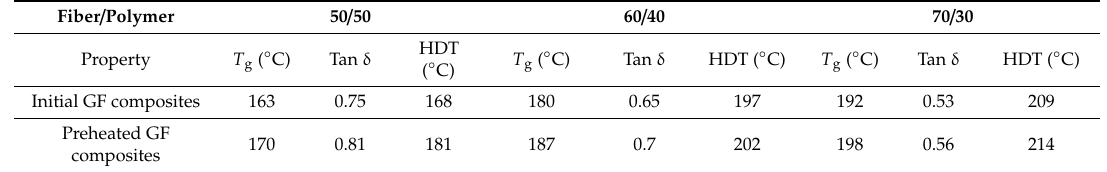
Table 1. The T g , tan δ , and HDT values for the composites reinforced with the initial and preheated